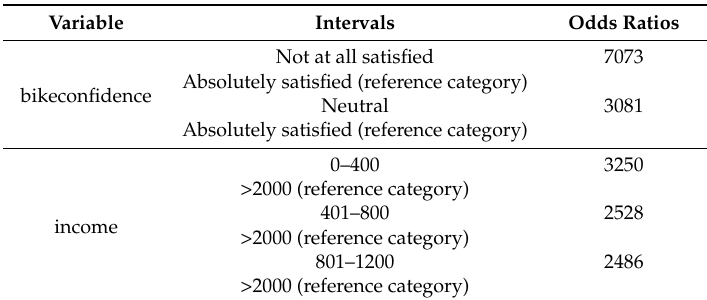
Table 4. Odds ratios results for the bicycle model.